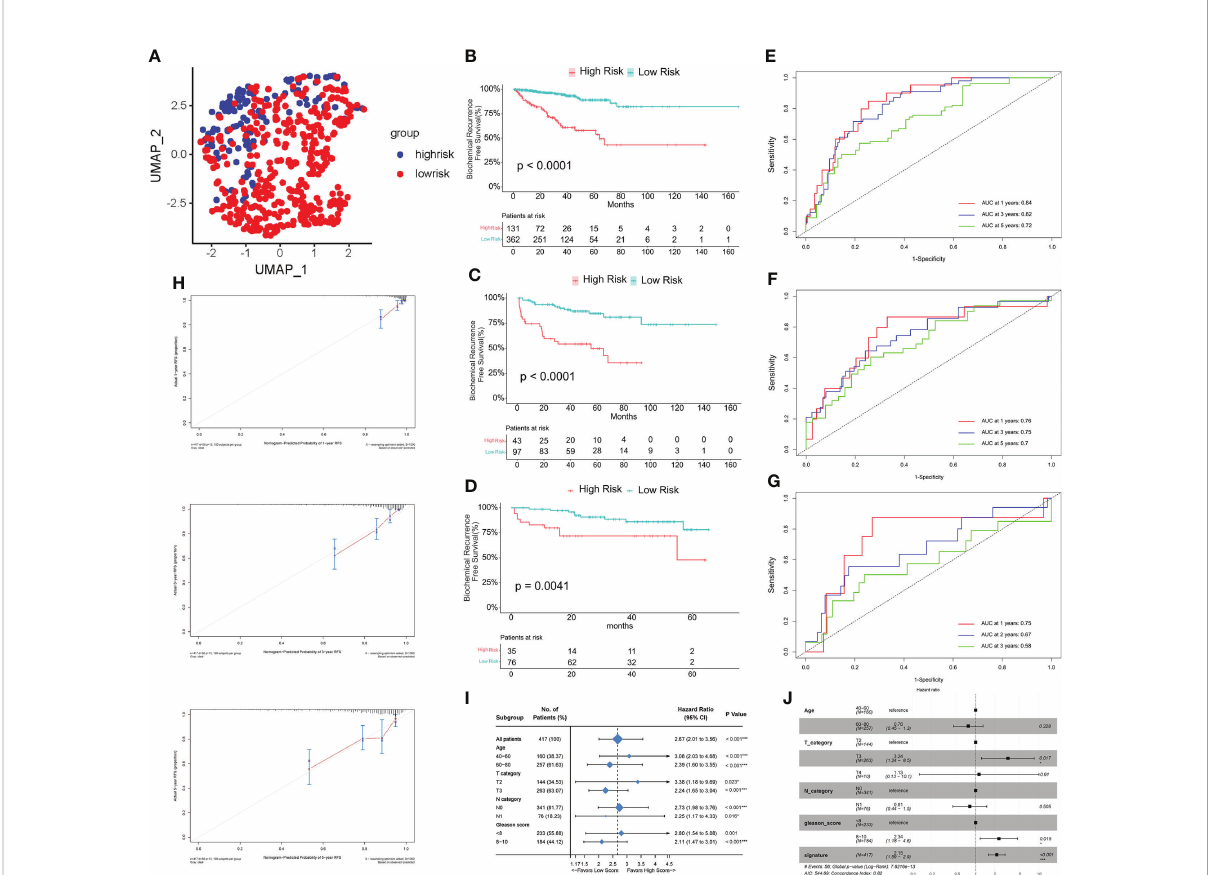
FIGURE 2 Assessment of the risk model. (A) Principal component analysis (PCA) of TCGA PRAD cohort. (B – D) Kaplan-Meier curves of RFS between high risk (HS) and low risk (LS) groups in TCGA (B) , MSKCC (C) , and GSE70770 (D) cohort. (E – G) Time-dependent receiver operating characteristic (ROC) analysis in TCGA (E) , MSKCC (F) , and GSE70770 (G) cohort. (H) Calibration plots for the nomogram: 1-, 3-, and 5- year nomogram. (I) Clinical subgroup analysis. (J) Univariate cox regression analysis of the clinical features and gene signature. (*P < 0.05, ***P <